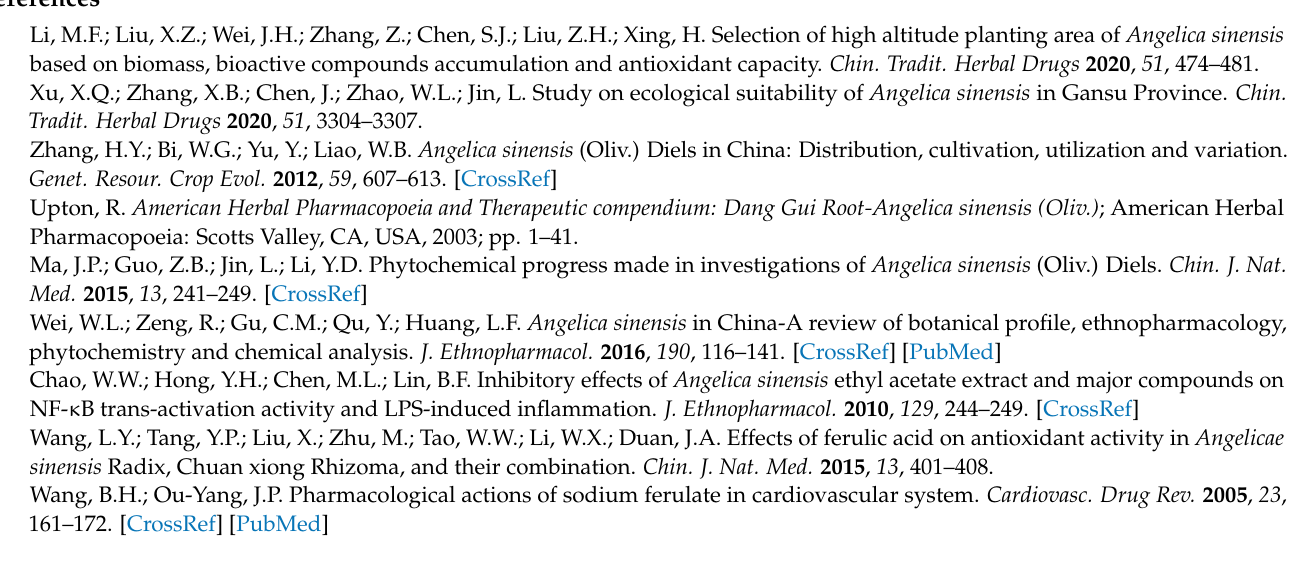
Table S1: Sequences of primer used in the qRT-PCR analysis; Table S2: Calibration curves of GA 1 , GA 4 , GA 8 , GA 9, and GA 20